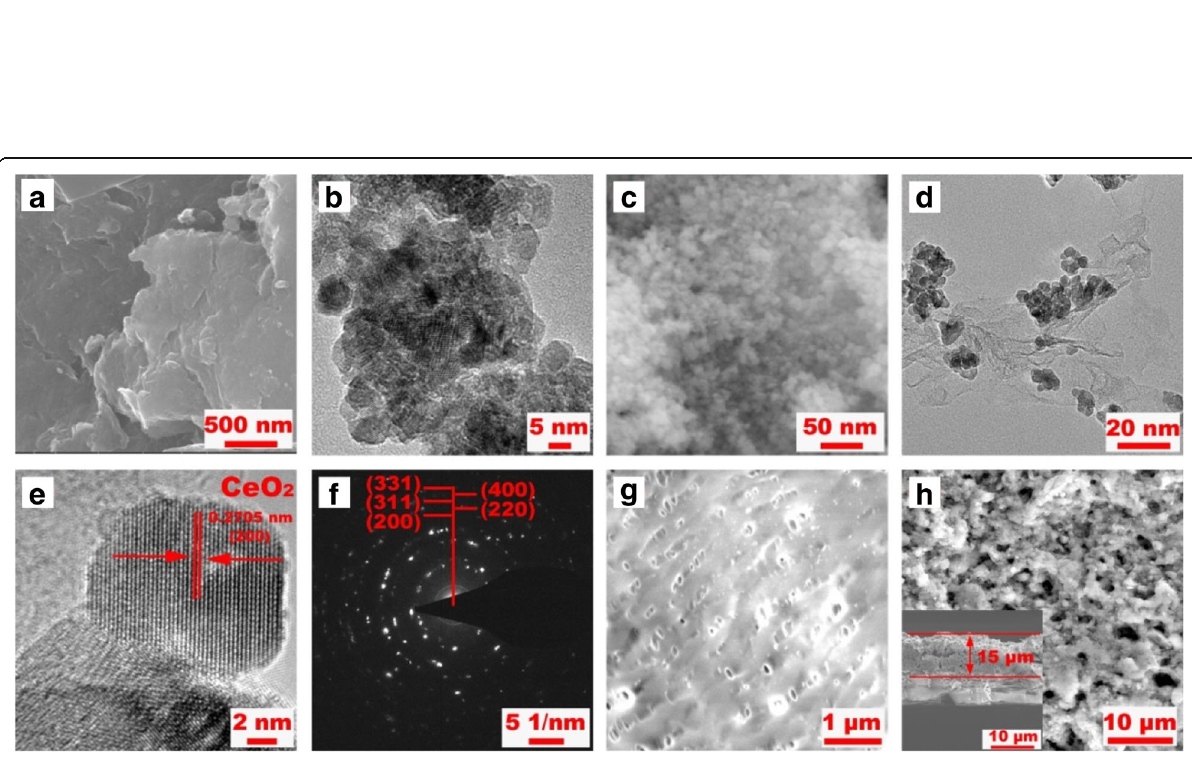
Fig. 3 SEM images of pure RGO ( a ), CeO 2 ( b ), and CeO 2 /RGO composite ( c ). Low-magnification TEM image of CeO 2 /RGO composite ( d ). HRTEM image for CeO 2 /RGO composite ( e ). SAED pattern of CeO 2 /RGO composite ( f ). Top-section SEM image of commercial separator ( g ) and modified separator ( h ). Cross-section SEM image of modified separator (inset to ( h ))